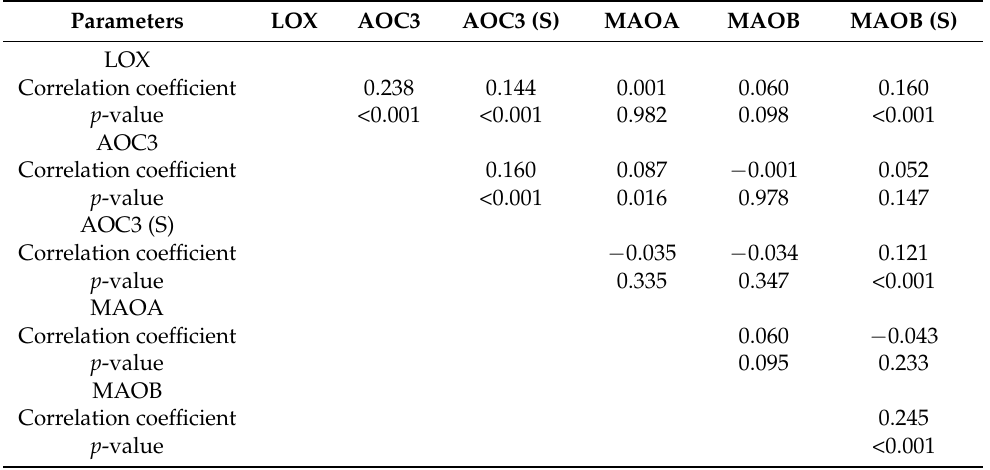
Table 3. Correlation of the expression of amine oxidase proteins breast